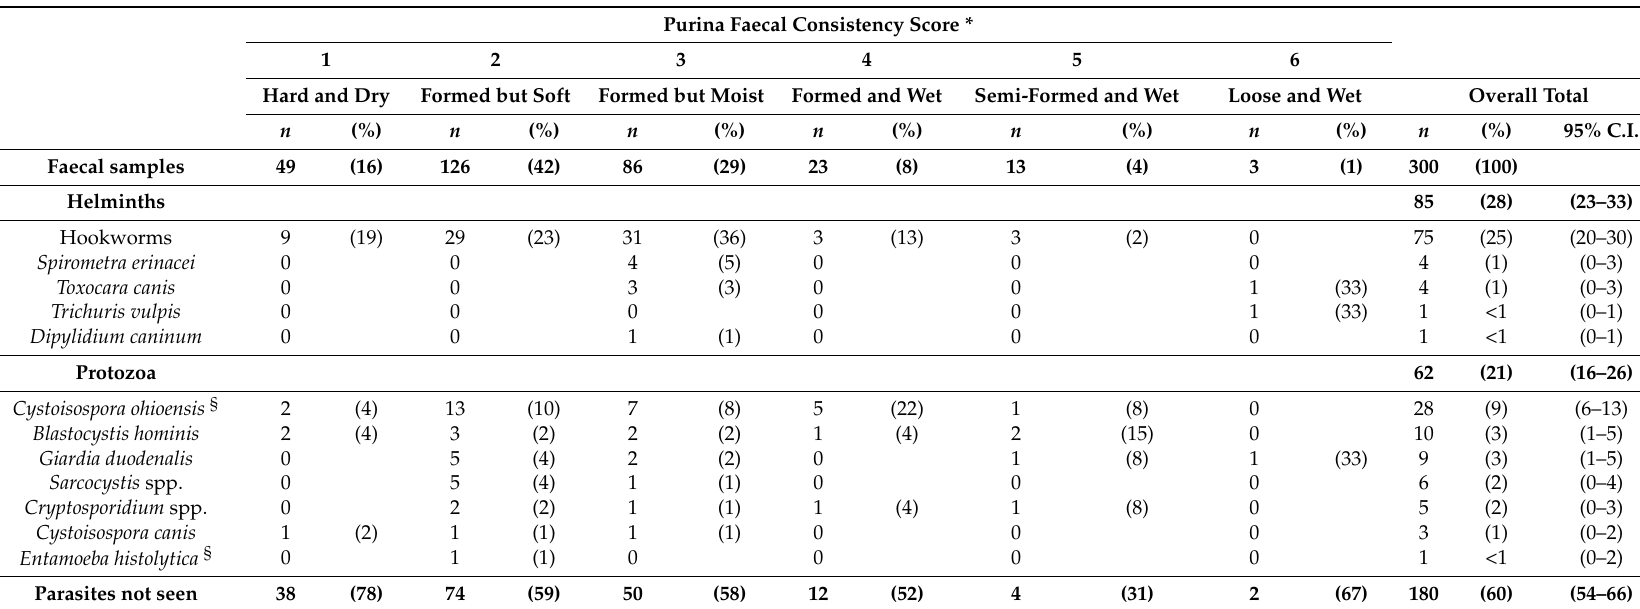
Table 1. Faecal consistency and associated intestinal parasites detected in a survey of domestic dog faecal samples collected in the greater Rockhampton region of Central Queensland between February and November